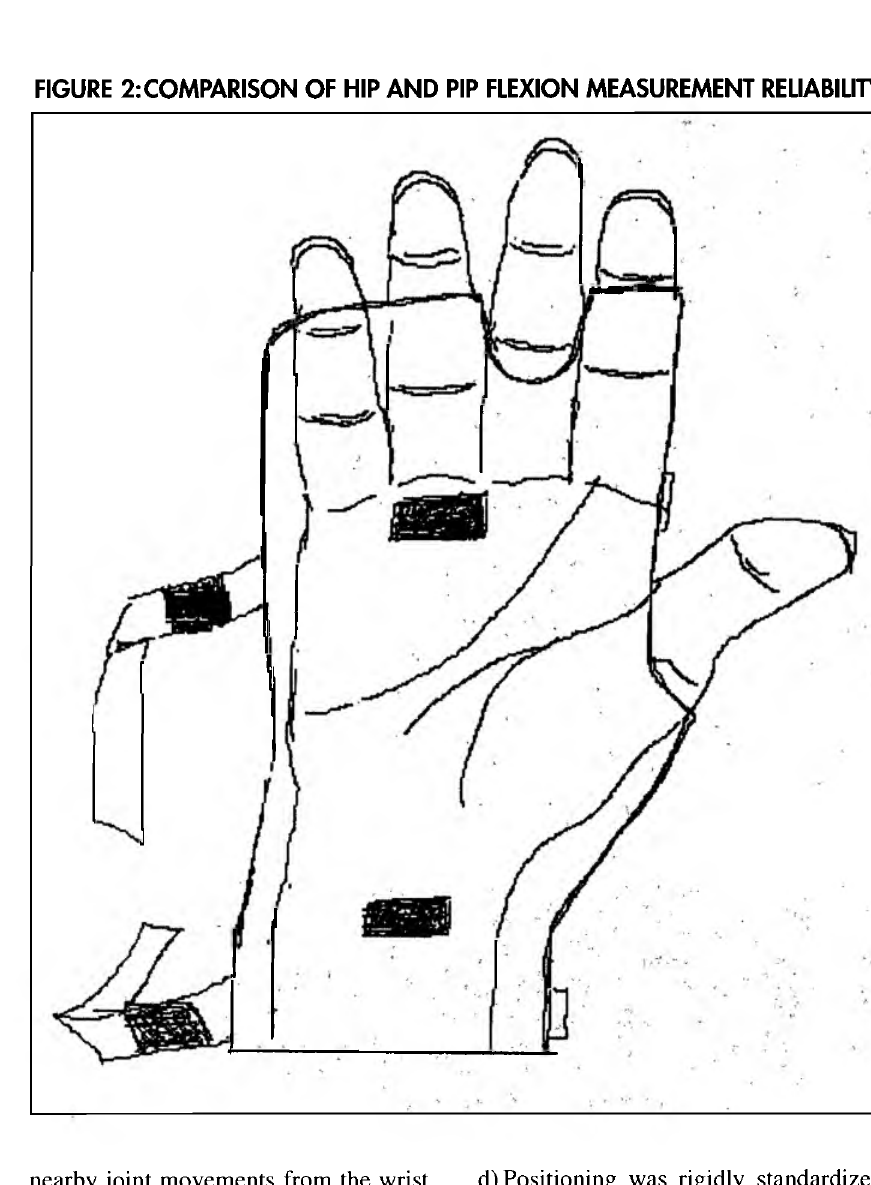
FIGURE 2: COMPARISON OF HIP AND PIP FLEXION MEASUREMENT